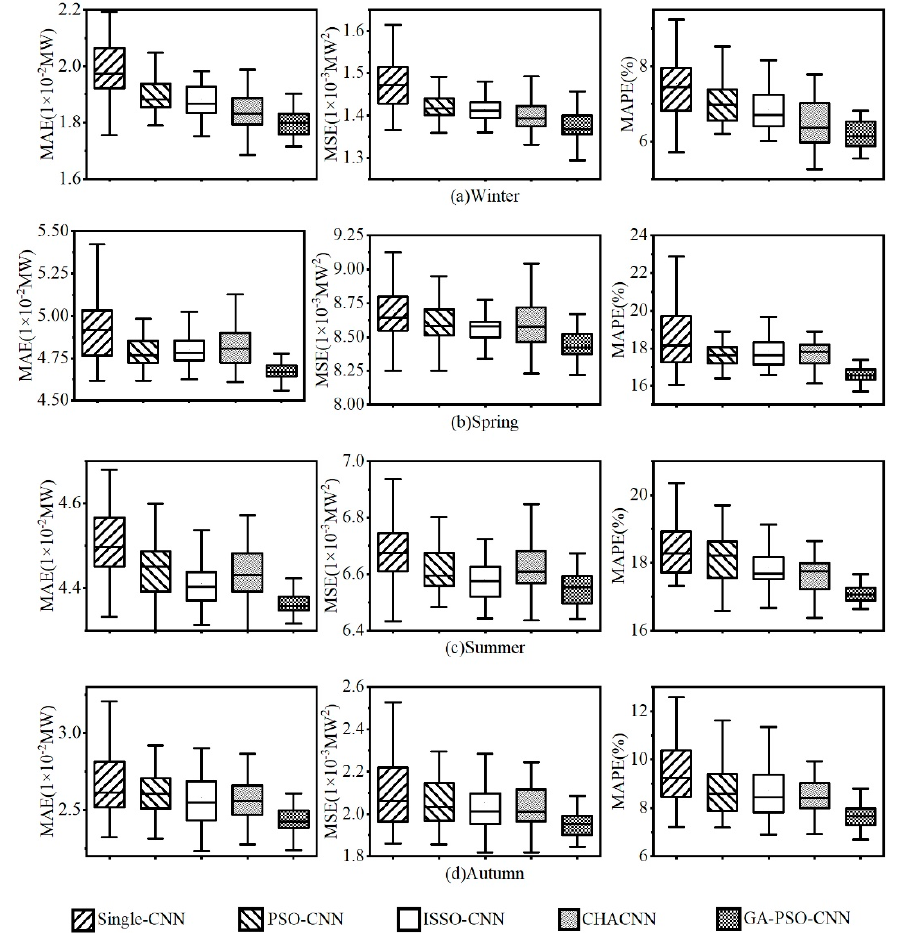
Figure 8. Performance metrics of models presented in box and whisker plots. ( a – d ) are the MAE, MSE and MAPE of the models in winter, spring, summer and autumn respectively